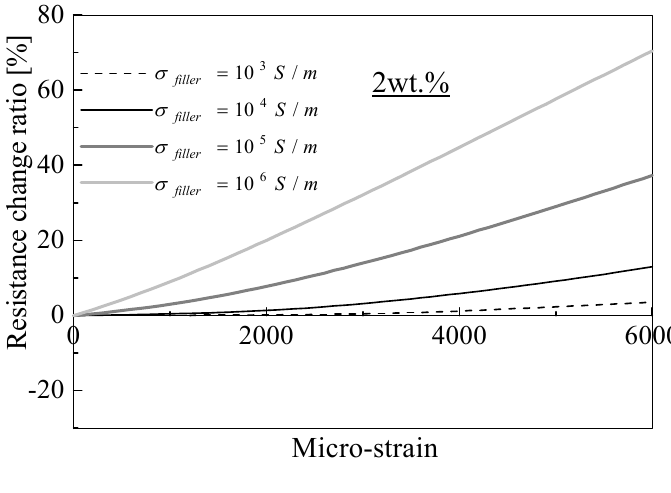
Figure 24. Influence of electrical conductivity of filler on sensor